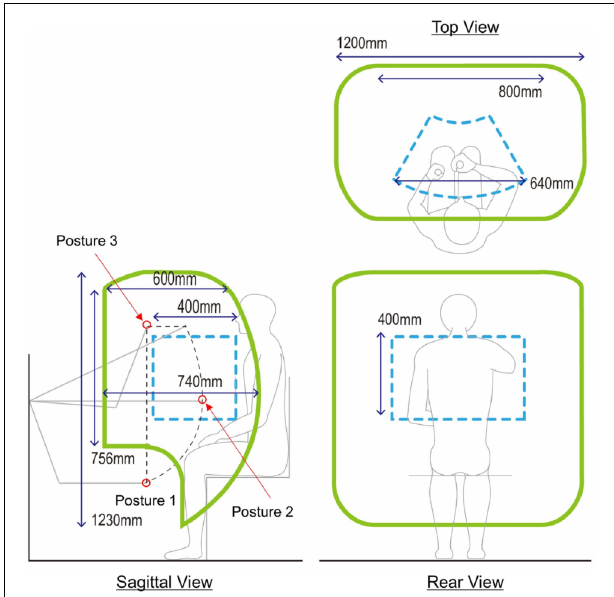
FIGURE 3 | Workspace of the handle. The three green contours represent the workspace of the handle projected in each of three planes. In the sagittal view, the black dotted contour represents workspace of the linear actuator positioner. Gray lines represent the posture of the linear actuator positioner at each position. At the three positions marked as red circles, mechanical stiffness of the link structure was tested (see section “Mechanical Stiffness of the Linear Actuator Positioner”). Workspace of HapticMaster is represented as blue dotted contours for comparison in each of the three